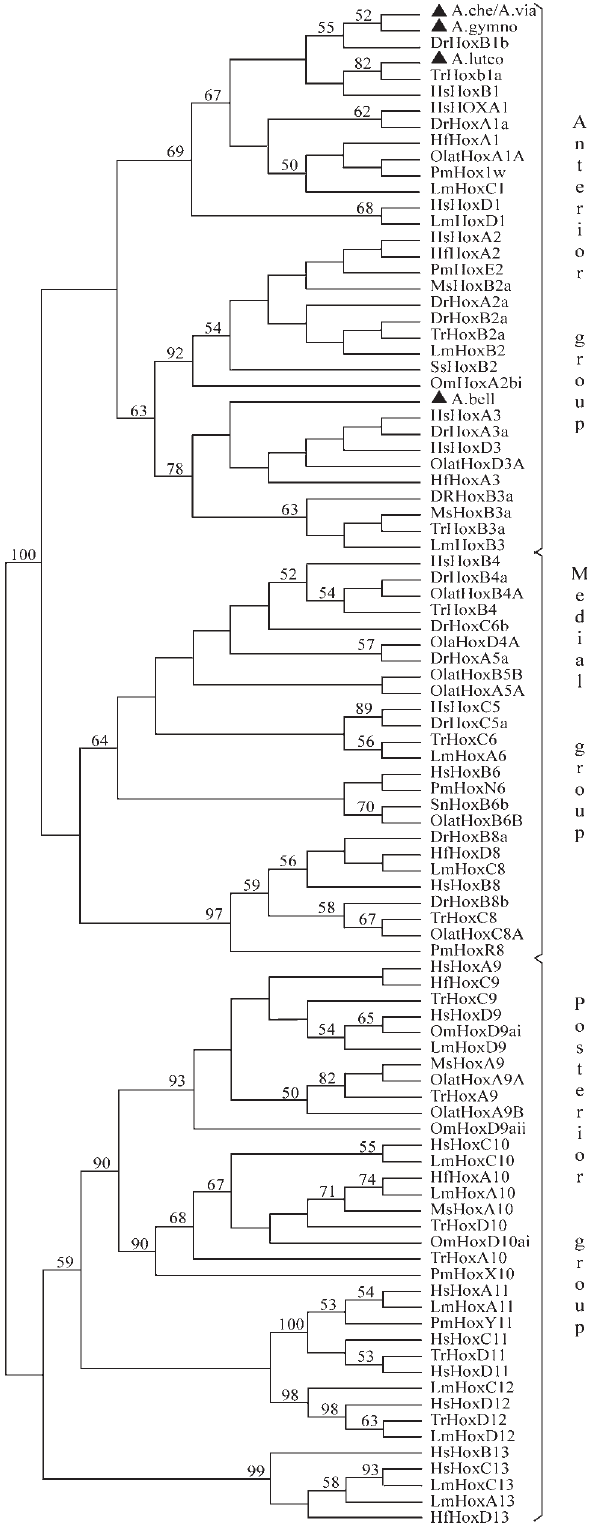
Figure 2 - Neighbor-joining tree using partial homeodomain amino acid sequences. The anterior (1-3), medial (4-8) and posterior (9-13) Hox paralogue groups are indicated. The Austrolebias species are marked with a black triangle (5). The number at each node represents bootstrap values above 50% recovered in 1000 replicates. GenBank accession numbers and abbreviations are given in Table